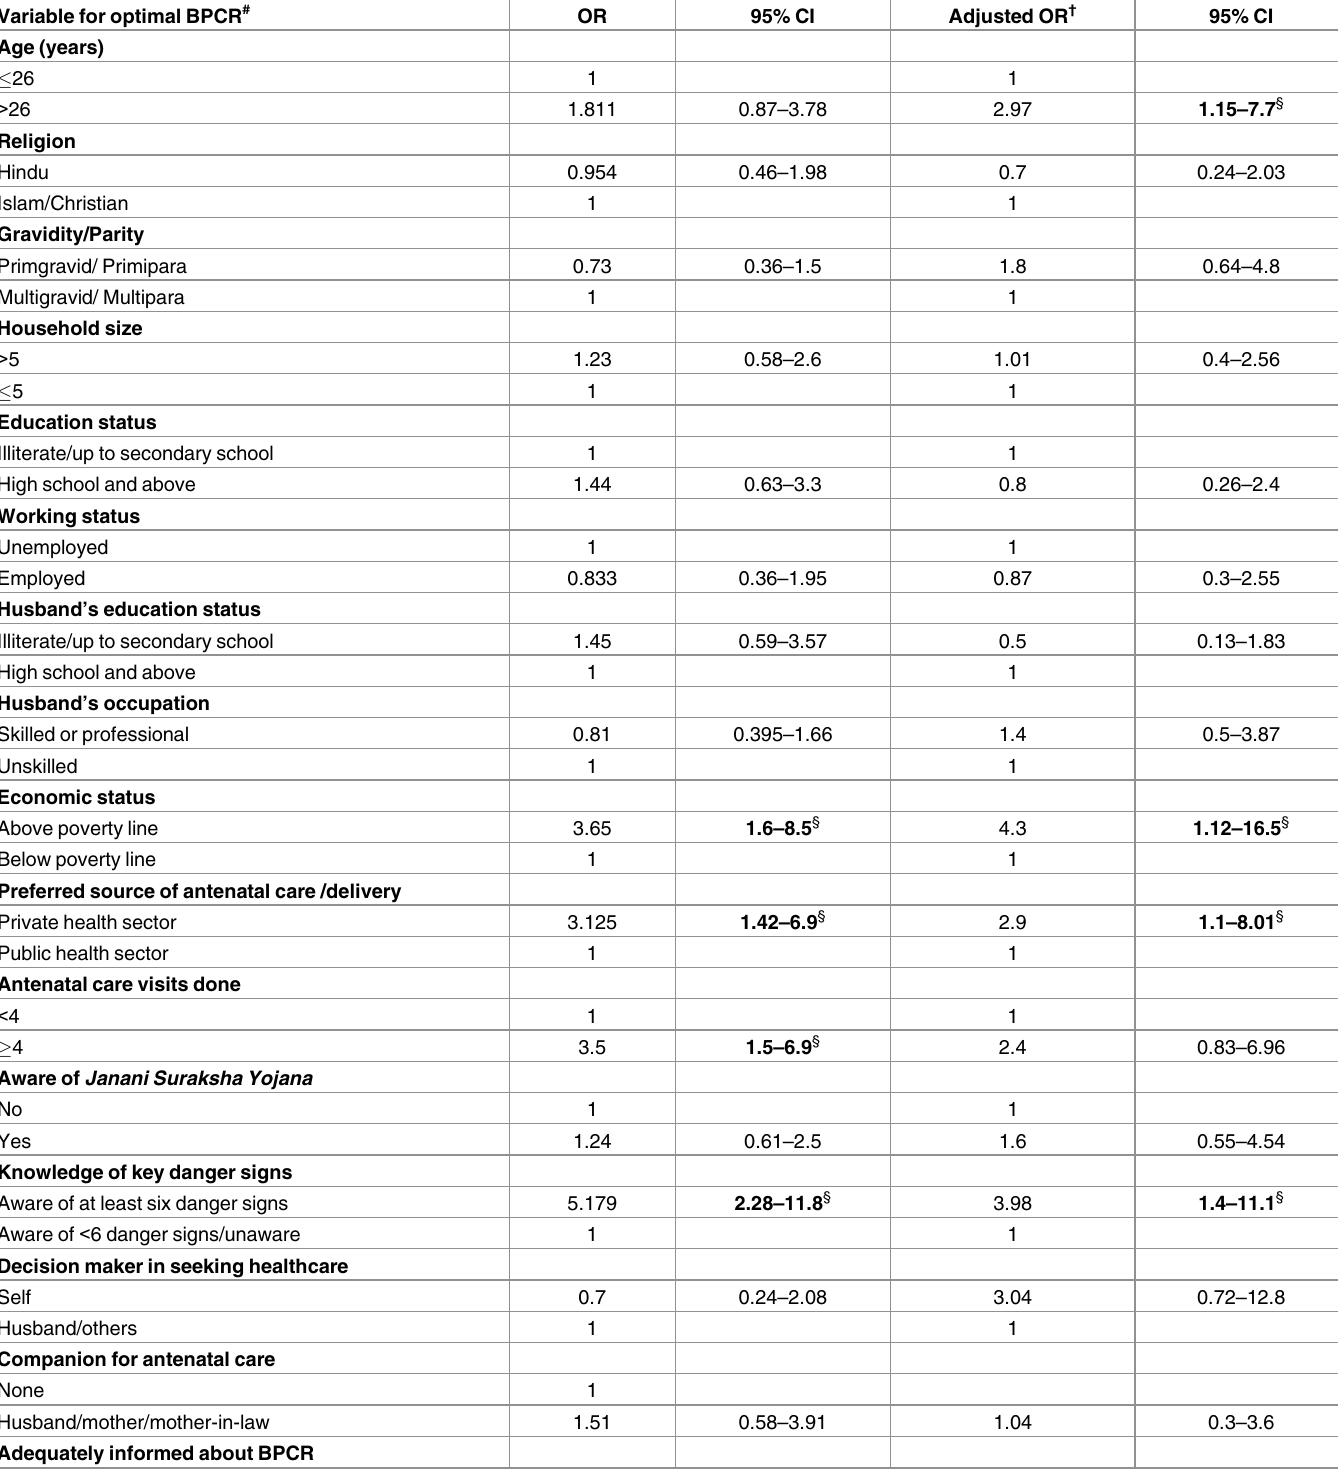
Table 3. Crude and adjusted Odds ratios (OR) for the optimal birth preparedness and complication readiness (BPCR) among women attending two rural primary health centers, Dakshina Kannada district, Karnataka,India, June-September 2013 (n =